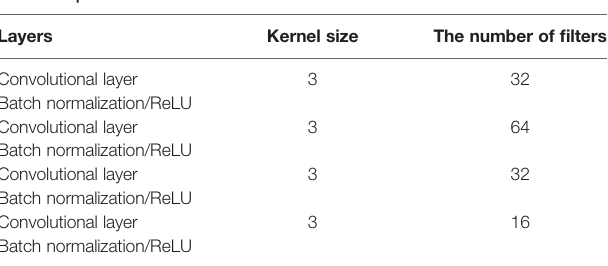
TABLE 1 | The structure of